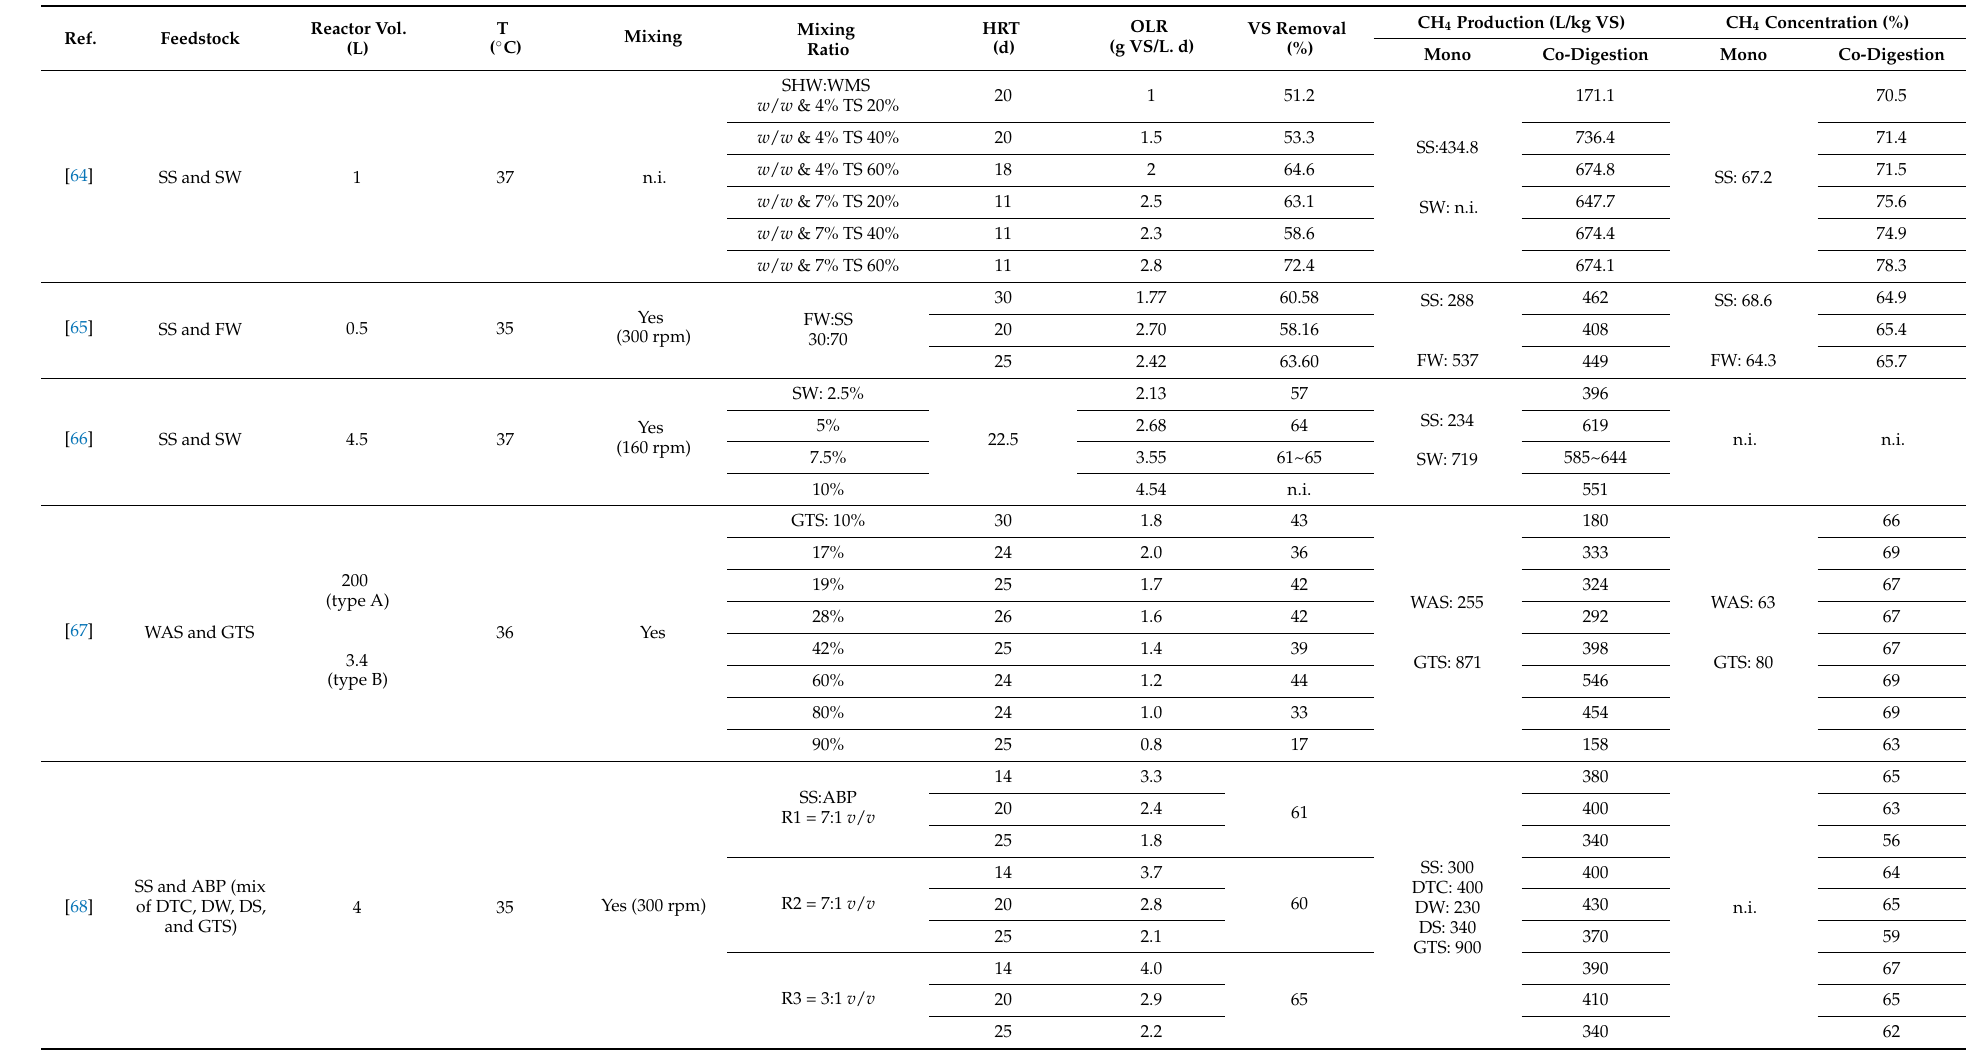
Table 2. Co-digestion studies of sewage sludge and different